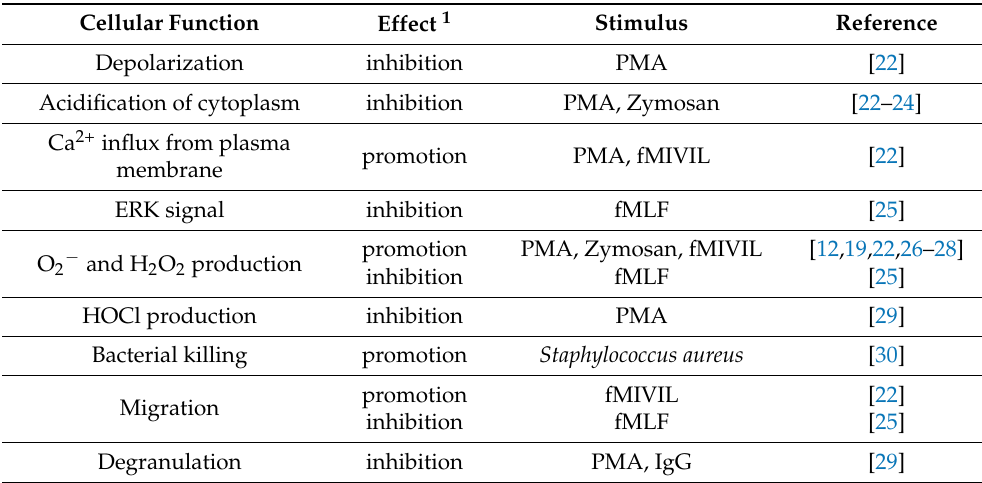
Table 1. Summary of Hv1/VSOP functions in